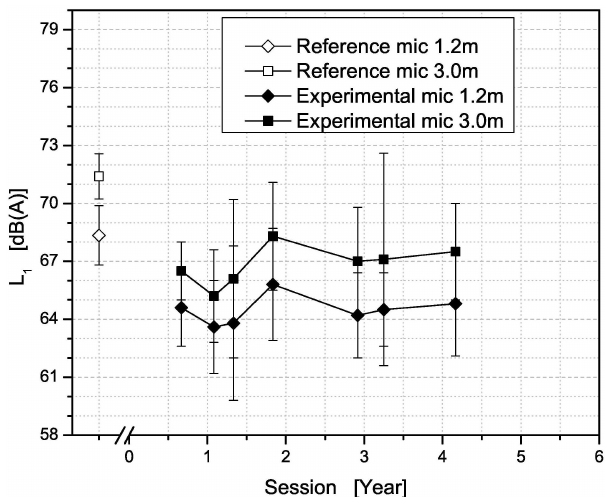
Figure 11. Time evolution of SPB values in Site 3. In white ante-operam values.